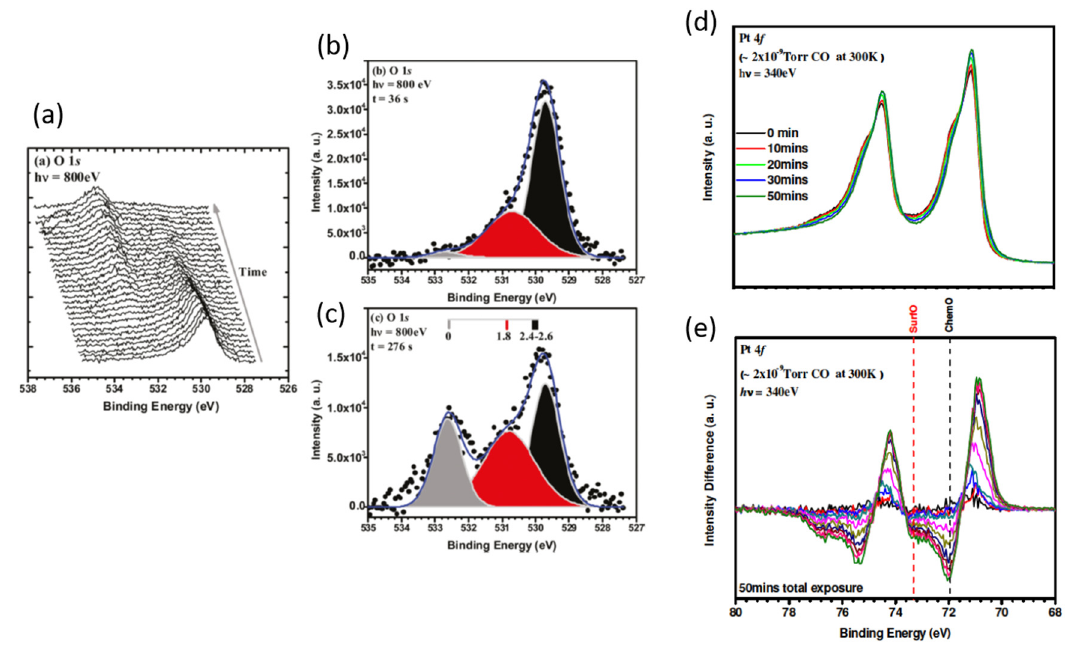
Figure 9. ( a ) Temporal variation in O 1s XPS during reaction of CO with a pre-oxidised Pt(110) surface. ( b ) and ( c ) Deconvolution of the O 1s at different states of the CO oxidation reaction into its three components at different time during reaction with CO. ( d ) and ( e ) Corresponding variations in Pt 4f XPS together ( d ) and ( e ) difference spectra made relative to the starting surface and shown the relative rates of remove of states due to chemisorbed O and those due to the removal of Pt surface oxide. Reproduced with permission from J. Am. Chem. Soc. 2011 , 133 , 20319–20325 [134]. Copyright 2011, American Chemical Society.